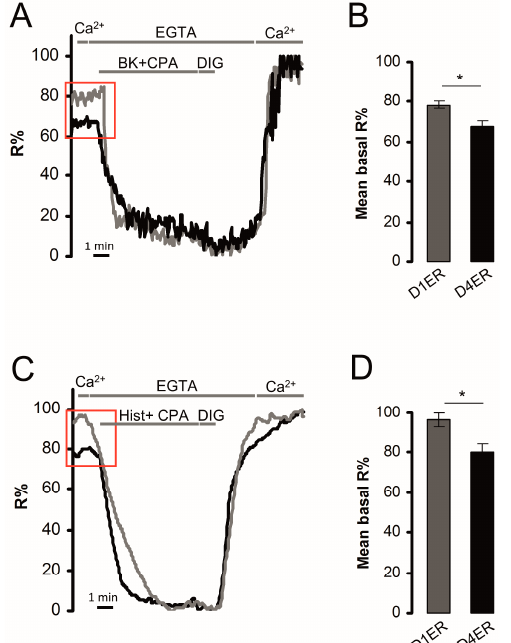
Figure 4. Basal ER Ca 2+ level evaluation. ( A ) The protocol described in Figure 1D has been applied to BHK cells expressing either D1ER or D4ER. Representative traces of D1ER (grey) and D4ER (black) kinetics are presented as R%; ( B ) the histogram depicts basal mean ER R% values obtained with the two probes in BHK cells; mean ± s.e.m., N ≥ 38 cells for each condition; ( C ) representative kinetics of ER R% values in HeLa cells expressing D1ER (grey) or D4ER (black). Live cells were stimulated with Hist (100 µ M) and CPA (20 µ M) in a Ca 2+ -free extracellular-like medium. Cells were then permeabilized with DIG (20 µ M) in an intracellular-like medium containing EGTA (600 µ M); then, an intracellular-like medium containing CaCl 2 (3 mM) was perfused; and ( D ) the histogram depicts the basal mean ER R% values obtained with the two probes in HeLa cells; mean ± s.e.m., N ≥ 25 cells for each condition, * = p < 0.05, unpaired Student’s t test.